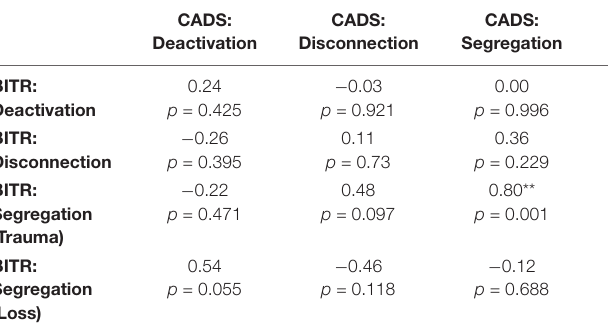
symptoms in the referred child post-treatment ( r s > 0.3 and/or p <